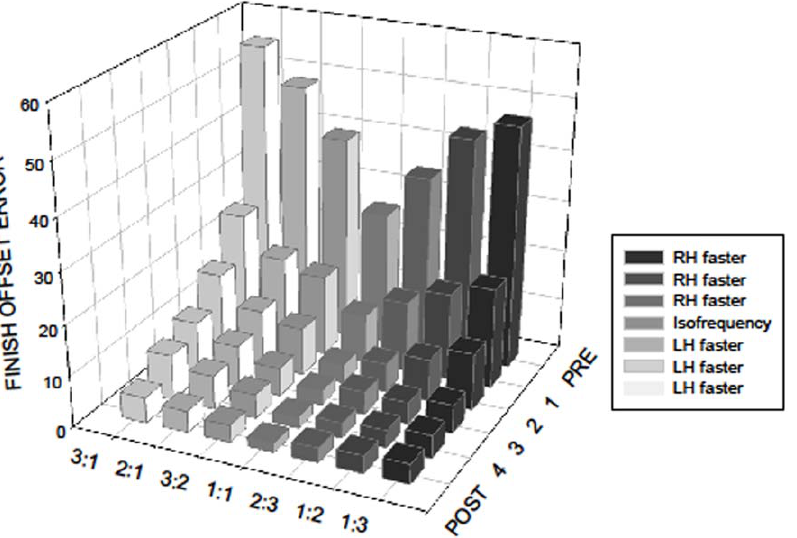
Figure 5. Four days of practice with augmented visual feedback overcomes all of the coordination constraints tested. doi:10.1371/journal.pone.0023619.g005 PLoS ONE |